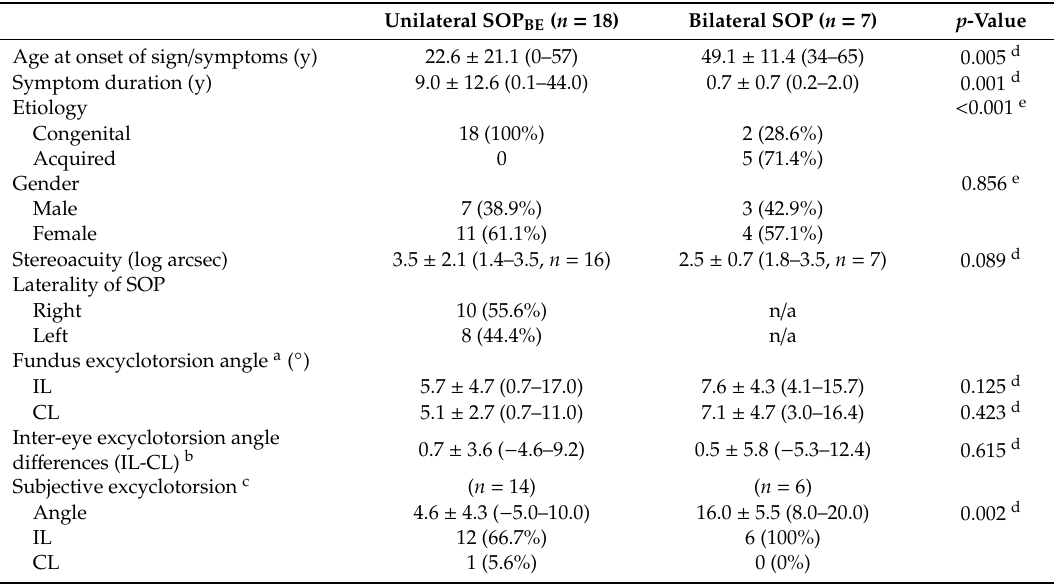
Table 1. Clinical characteristics of subjects with bilateral fundus excyclotorsion in unilateral superior oblique palsy (SOP) and bilateral